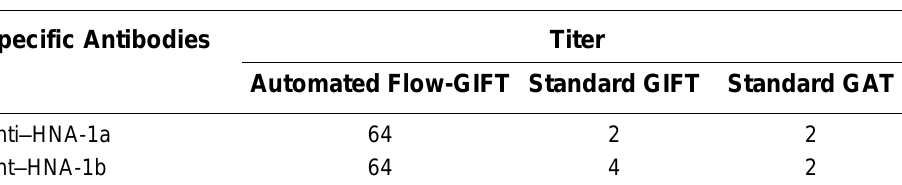
64 — 16 The titers in automated Flow-GIFT, standard GIFT, and standard GAT are depicted. The automated Flow-GIFT proves to be more sensitive than standard GIFT and/or